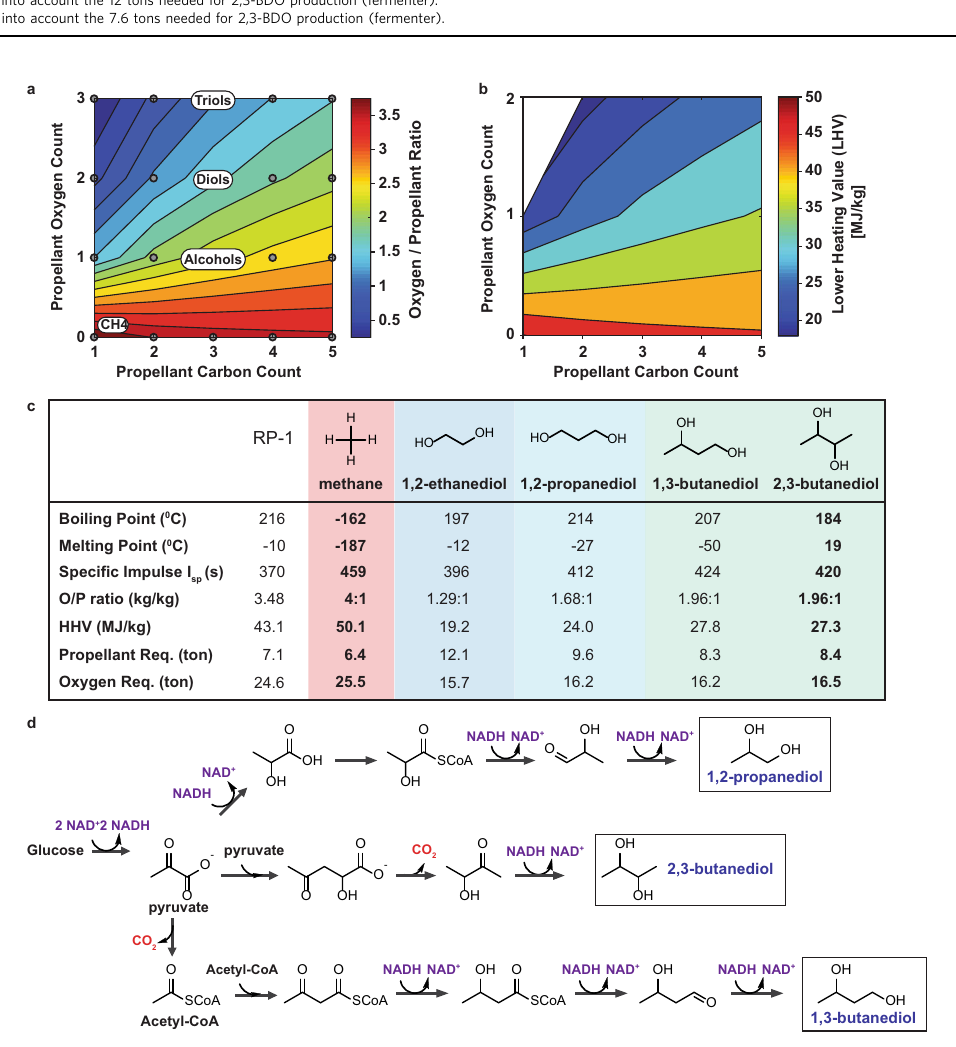
Fig. 2 Martian rocket propellant design. a Relationship between increasing the number of oxygen and carbon atoms in the propellants to the mass of oxygen needed for complete combustion, i.e. oxygen/propellant ratio (O/P ratio). Increasing the number of oxygen atoms in the propellant reduces the mass of external oxygen needed for full combustion. b Relationship between increasing the number of oxygen and carbon atoms in the propellant to its lower heating value (LHV). Increasing the number of oxygen atoms in the propellant reduces its LHV. c Propellant relevant properties for Rocket Propellant-1 (RP-1), used for spacecraft launch from Earth, methane, and proposed Martian rocket propellants: 1,2-ethanediol, 1,3-propanediol, 1,3- butanediol, and 2,3-butanediol. Theoretical speci fi c impulses ( I sp ) were calculated using Eq. (3). Mass of propellant required was calculated using the ideal rocket equation (Eq. (4)). d Short-chain diol metabolic pathways from glucose. Both 1,2-propanediol and 1,3-butanediol require excess NADH. Carbon dioxide evolved: red. NADH consumed: purple. Name of short-chain diols: blue. Source data underlying Fig. 2c are provided as a Source Data fi